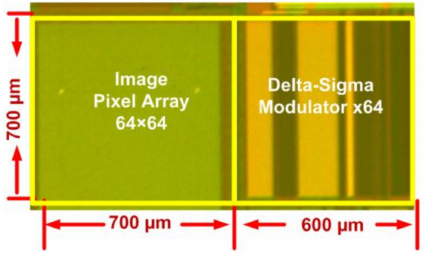
Figure 5. Chip micrograph of the CMOS image sensor (CIS) under test.